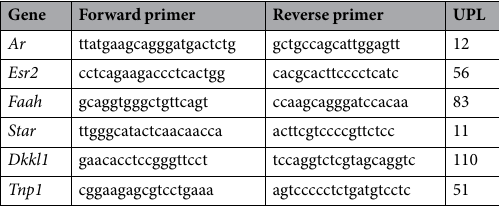
Table 1. Primer sequences and probes used for